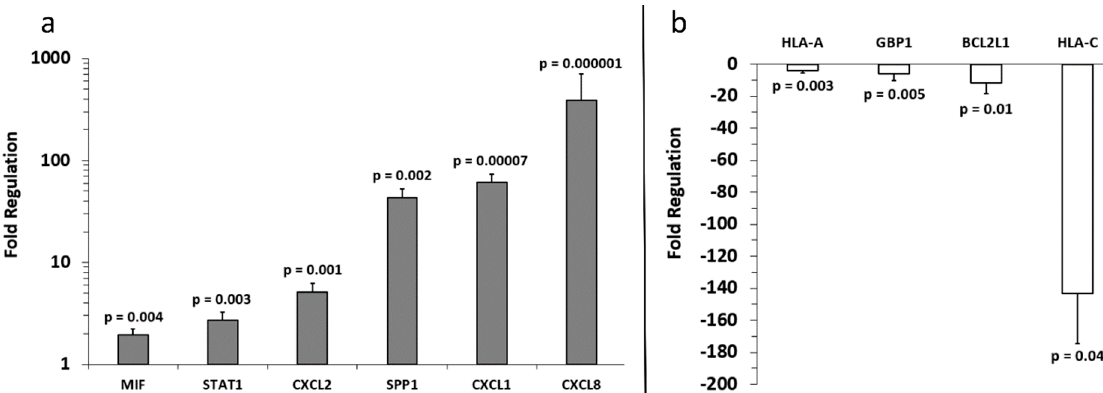
Figure 4. Fold regulation of SKMEL-28 melanoma sEV mRNA versus control primary melanocyte sEV mRNA. ( a ) Increased and ( b ) decreased gene expression levels relative to primary melanocytes (normalized to 1) are shown. Three independent sEV batches were pooled and run on ( n = 3) replicate arrays, error bars = SD, p values <0.05 were considered statistically significant.